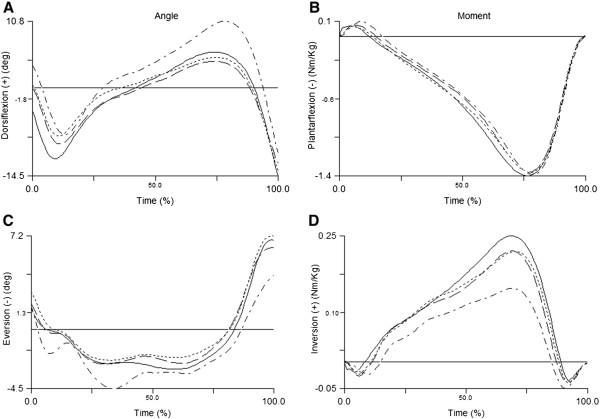
Ensemble curves of ankle sagittal plane angle (A) and moment (B) and frontal plane angle (C) and moment (D) of all four footwear conditions, where the solid line is for barefoot, dash line for sandals, dotted line for flip-flops, and dash-dotted line for shoes.